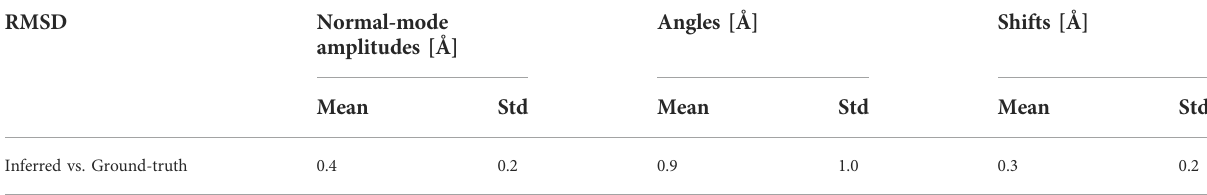
TABLE 2 Mean and standard deviation (Std) of the distance between inferred and ground-truth parameters from Table 1 (for a small test set of 2,000 synthetic images), but expressed in RMSD terms. RMSD Angles [Å]